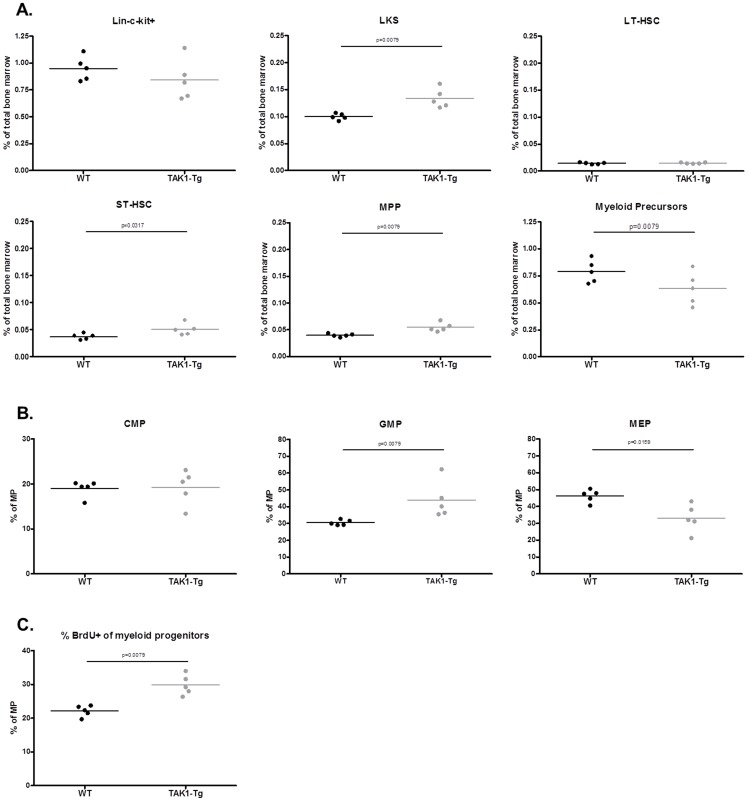
TAK1 knockdown increases proliferation and differentiation of myeloid precursors in the bone marrow.Wildtype (WT) and TAK1 shRNA transgenic mice (TAK1-Tg) were treated with 0.2 mg/ml doxycycline in the drinking water for two weeks. Mice (n = 5 each group) were sacrificed and spleens and bone marrow were harvested. (A) Lin−c-Kit+ progenitors, Lin−c-Kit+Sca-1+ cells (LKS population), LT-HSCs (CD34−Flt3−), ST-HSC (CD34+Flt3−), MPPs (CD34+Flt3+) and myeloid precursors (Lin−c-Kit+Sca-1−) were characterized by flow cytometry using the indicated cell markers. (B) Subpopulation of the myeloid precursors were characterized using the following markers: GMPs (CD34+CD16/32+), MEPs (CD34−CD16/32−) and CMPs (CD34+CD16/32low). (C). Using staining with antibodies specifically recognizing BrdU, proliferating cells in the myeloid precursors (Lin−c-Kit+Sca-1−) were identified. Statistical significance was determined using the two-tailed test (p<0.05).